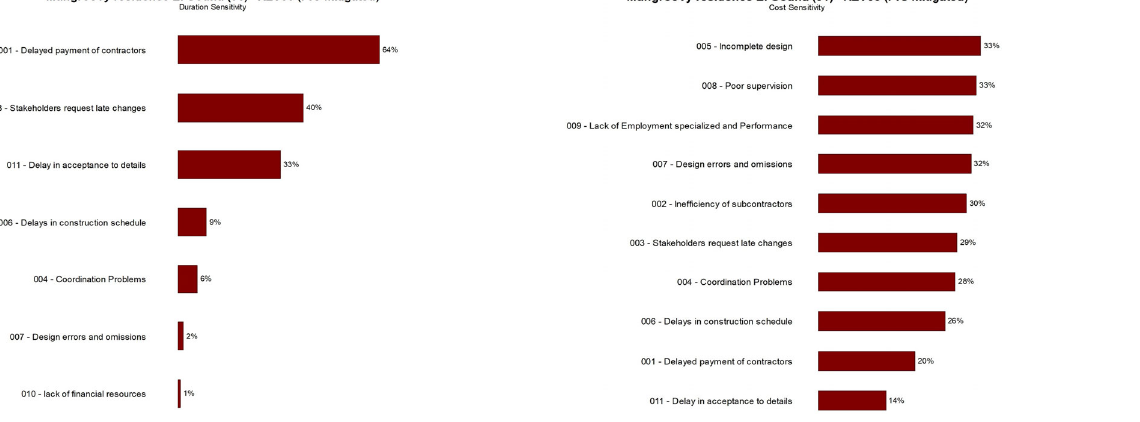
Fig. 11. Sensitivity analysis – cost sensitivity Fig. 11. Alt Text: Sensitivity analysis – cost sensitivity: